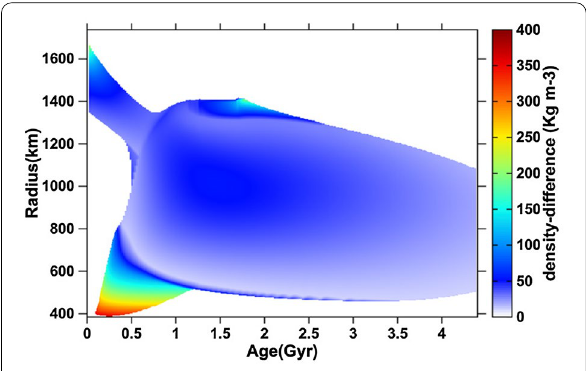
Fig. 8 The evolution of the distribution of density difference between magma and matrix �ρ (Eq.